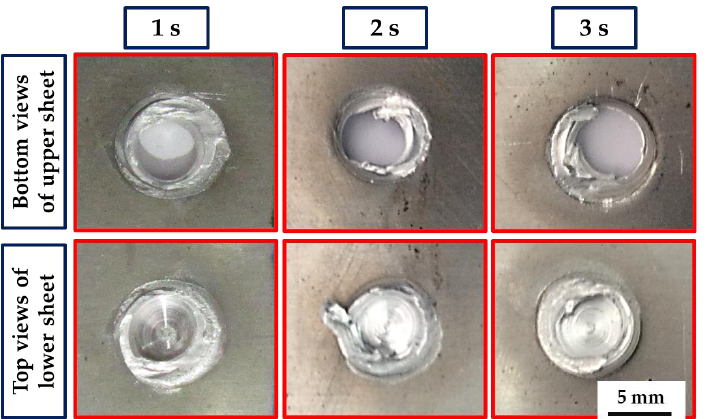
Figure 12. Photographs of the failed specimens of AA5052-H32 FSSW joints after tensile shear testing.